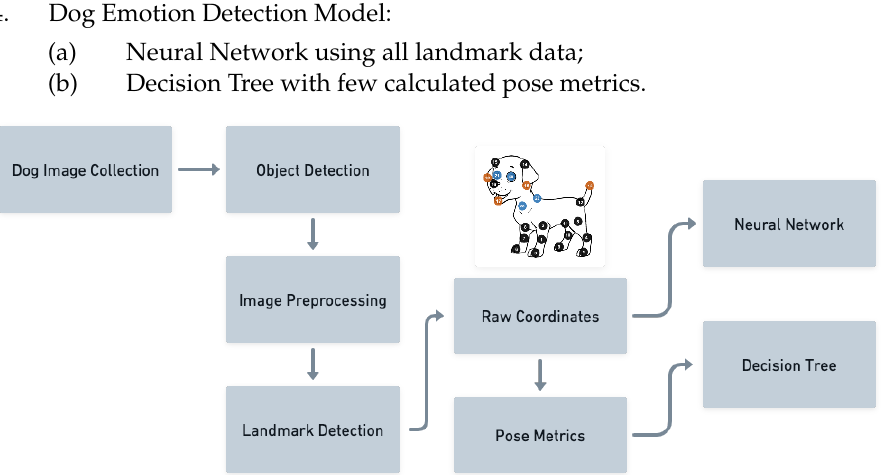
Figure 1. Workflow diagram of the proposed